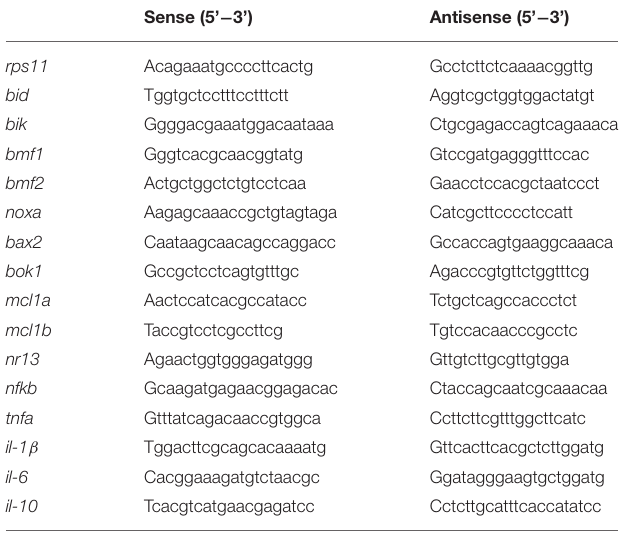
TABLE 2 | Quantitative PCR